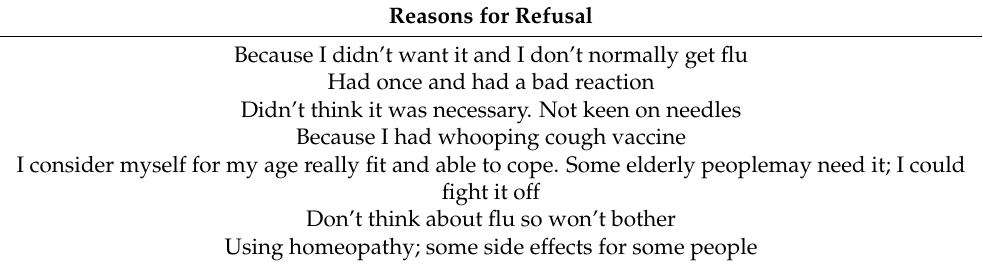
Table 2. Individual patients’ negative responses to question, “This current winter, will you get a seasonal flu